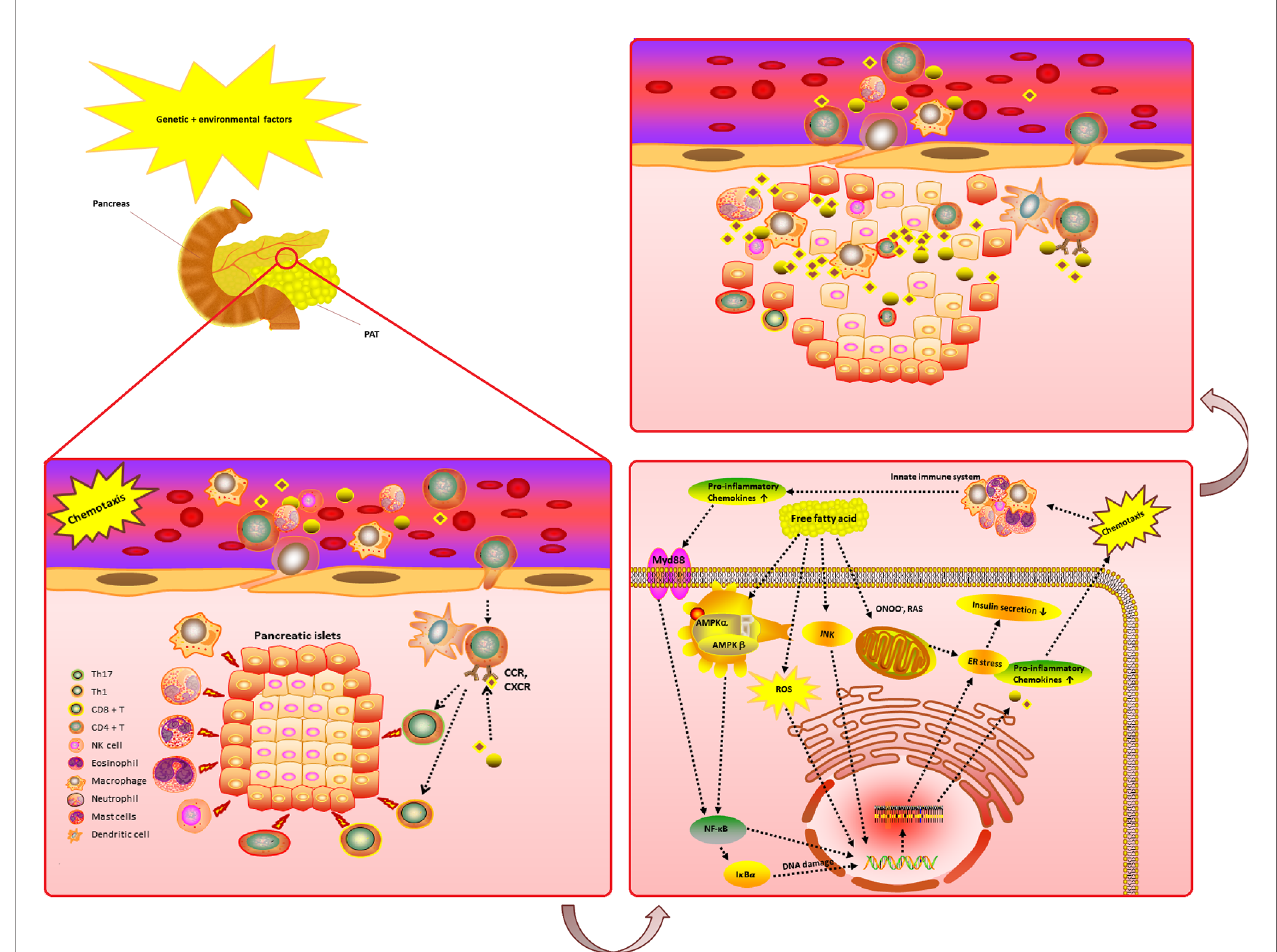
FIGURE 3 | The complicated chemokines and their receptors network in the microenvironment of T2DM. The chemokine system plays a variety of roles in the T2DM microenvironment. Pancreatic islets and PAT are exposed to an early damage by genetic or environmental factors and start to secrete numerous pro- in fl ammatory chemokines. The chemokines and their receptors can also cause a variety of immune cells to enter the pancreatic islets and PAT site to play the role of immune attack. Pro-in fl ammatory chemokines are bind to their receptors activating the NF- k B/I k B a and AMPK activation pathway, which stimulates a proin fl ammatory condition. Free fatty acid may also activate in fl ammatory pathways and DNA damage. As a result of the Free fatty acid dysfunction, superoxide and subsequently hydrogen peroxide generation (which can combine with nitric oxide, an example of ONOO-, to create peroxynitrite, such as ROS/RNS) may occur due to compromised mitochondrial ETC and reducing ATP synthesis. All these processes impact ER stress, leading to a reduction in the ability to secrete insulin. Moreover, T2DM progression is characterized by progressive secretion of pro-in fl ammatory chemokines/cytokines caused by b cell damage. Due to this process, various immune cell types (i.e., neutrophils, macrophages, NK cell, dendritic cell and speci fi cally T cells) are recruited in the pancreatic tissue. These immune cells further release more innate in fl ammatory cytokines, which contribute to a rapid increase b cell death. T2DM, Type 2 diabetes mellitus; ROS, reactive oxygen species; RNS, reactive nitrogen species; NF- k B/I k B a , nuclear factor-kappaB; ATP, adenosine triphosphate; PAT, peri-pancreatic adipose tissue; CCR, CC chemokines receptor; CXCR, CXC chemokines receptor; ETC, electron transport chain; AMPK, Adenosine 5-monophosphate activated protein-kinase; ER, endoplasmic reticulum; Protein kinase B (AKT); ONOO-, peroxynitrite; GLUT, glucose transporters; NK, Natural killer; Tregs, Regulatory T cells. (Drawn by